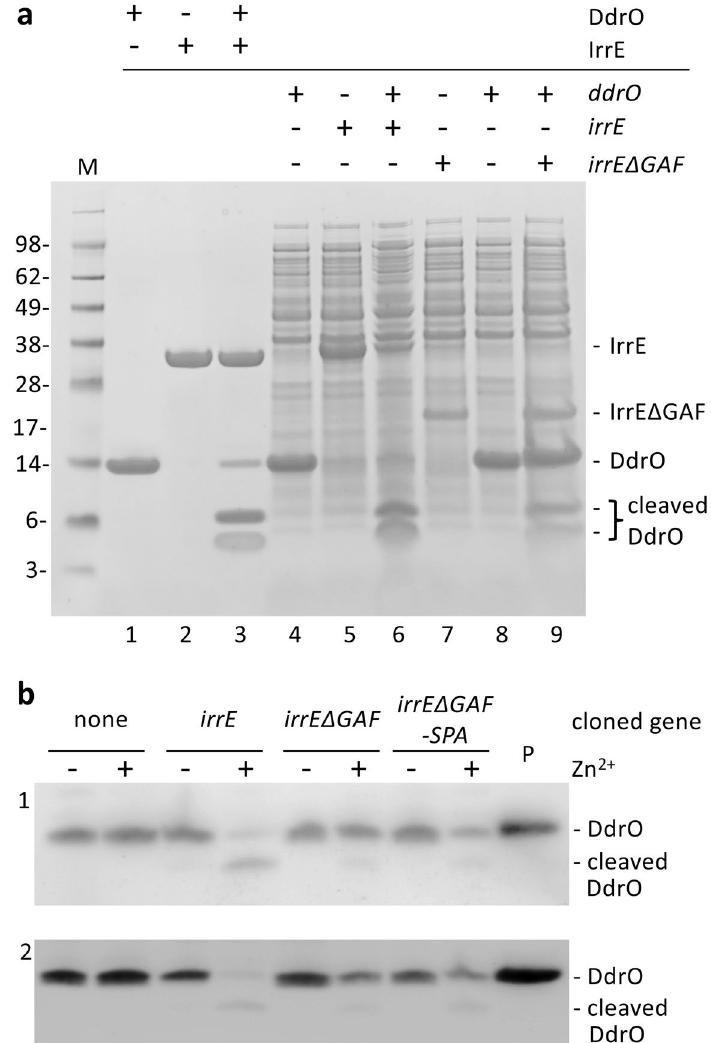
Figure 5. DdrO cleavage by a truncated IrrE lacking its GAF-like domain. ( a ) SDS-PAGE showing cleavage of DdrO when co-expressed with IrrE or IrrE lacking its GAF-like domain (IrrEΔGAF) in E. coli (lanes 4 to 9). The same gel contains purified DdrO (lane 1), IrrE (lane 2) and the products of in vitro cleavage (10 min 37 °C; lane 3). IrrE and IrrEΔGAF have an N-terminal His-tag, DdrO a C-terminal His-tag. M, molecular weight marker proteins (masses in kDa). ( b ) Western blots showing induced cleavage of DdrO by IrrEΔGAF in D. deserti . Strain RD42 (Δ irrE ) was transformed with a derivative of plasmid pI3 containing the indicated cloned gene, and DdrO cleavage was analyzed after zinc shock (250 μM for 10 min). In IrrEΔGAF-SPA, the GAF-like domain is replaced by a SPA-tag. Except for the strain without cloned gene, induced DdrO cleavage is (faintly) visible in each strain (appearance of cleavage product and decrease of intact DdrO). The cropped blots (1 and 2) are from two independent series of experiments (uncropped blots are shown in Supplementary Fig. S9). A third independent experiment is shown in Supplementary Fig. S8. P, 20 ng purified